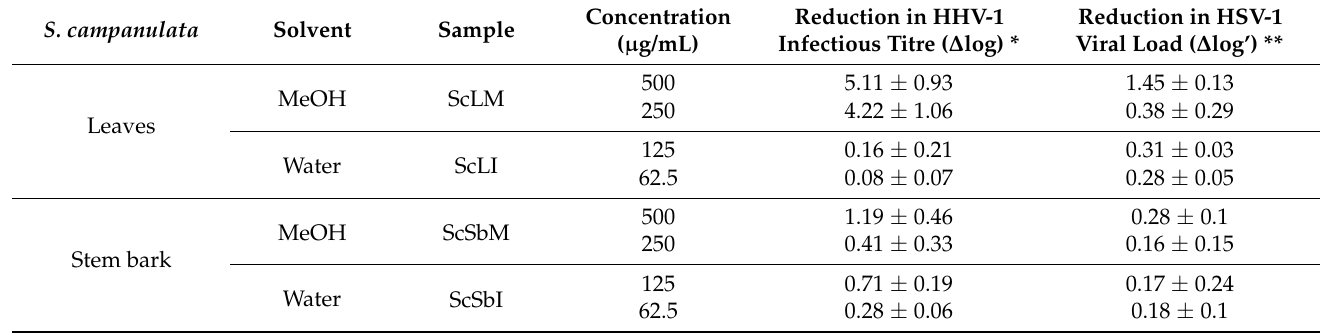
Table 4. Influence of S. campanulata extracts on HHV-1 infectious titre and viral load in virus-infected VERO